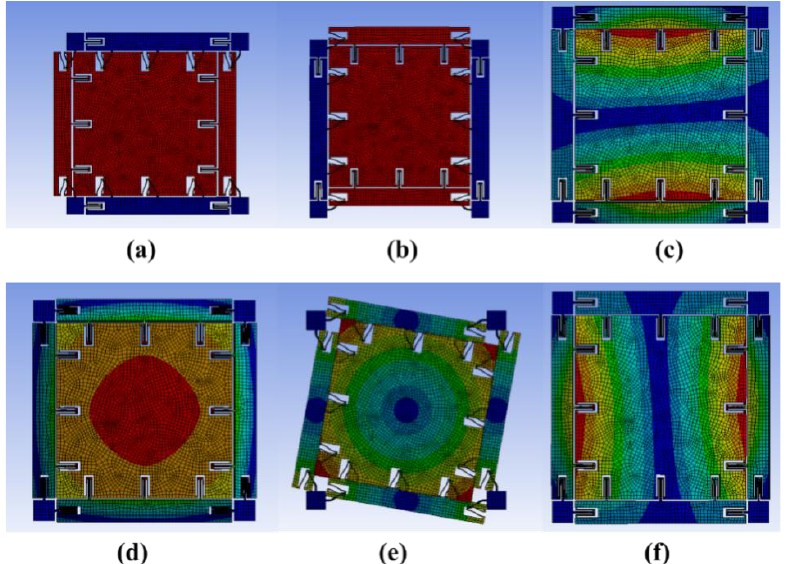
Figure 2. Circuit structure of MEMS gyroscope.